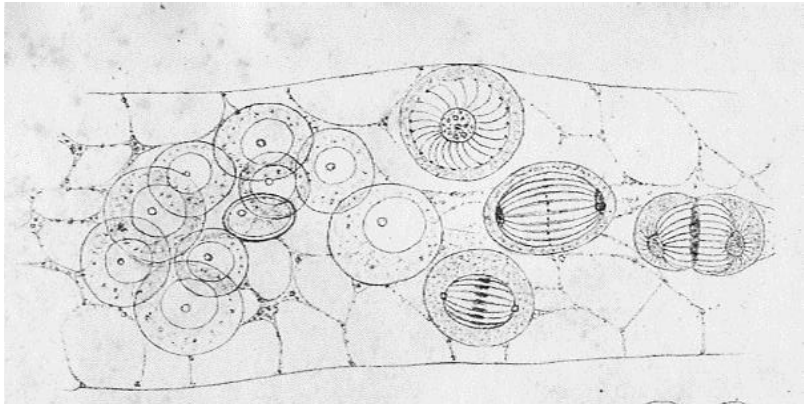
Figure 2. Drawing of mitotic figures that indicate structures at the spindle poles. van Benedin, 1876 [3] Image courtesy of Biodiversity Heritage Library. http://www.biodiversitylibrary.org.